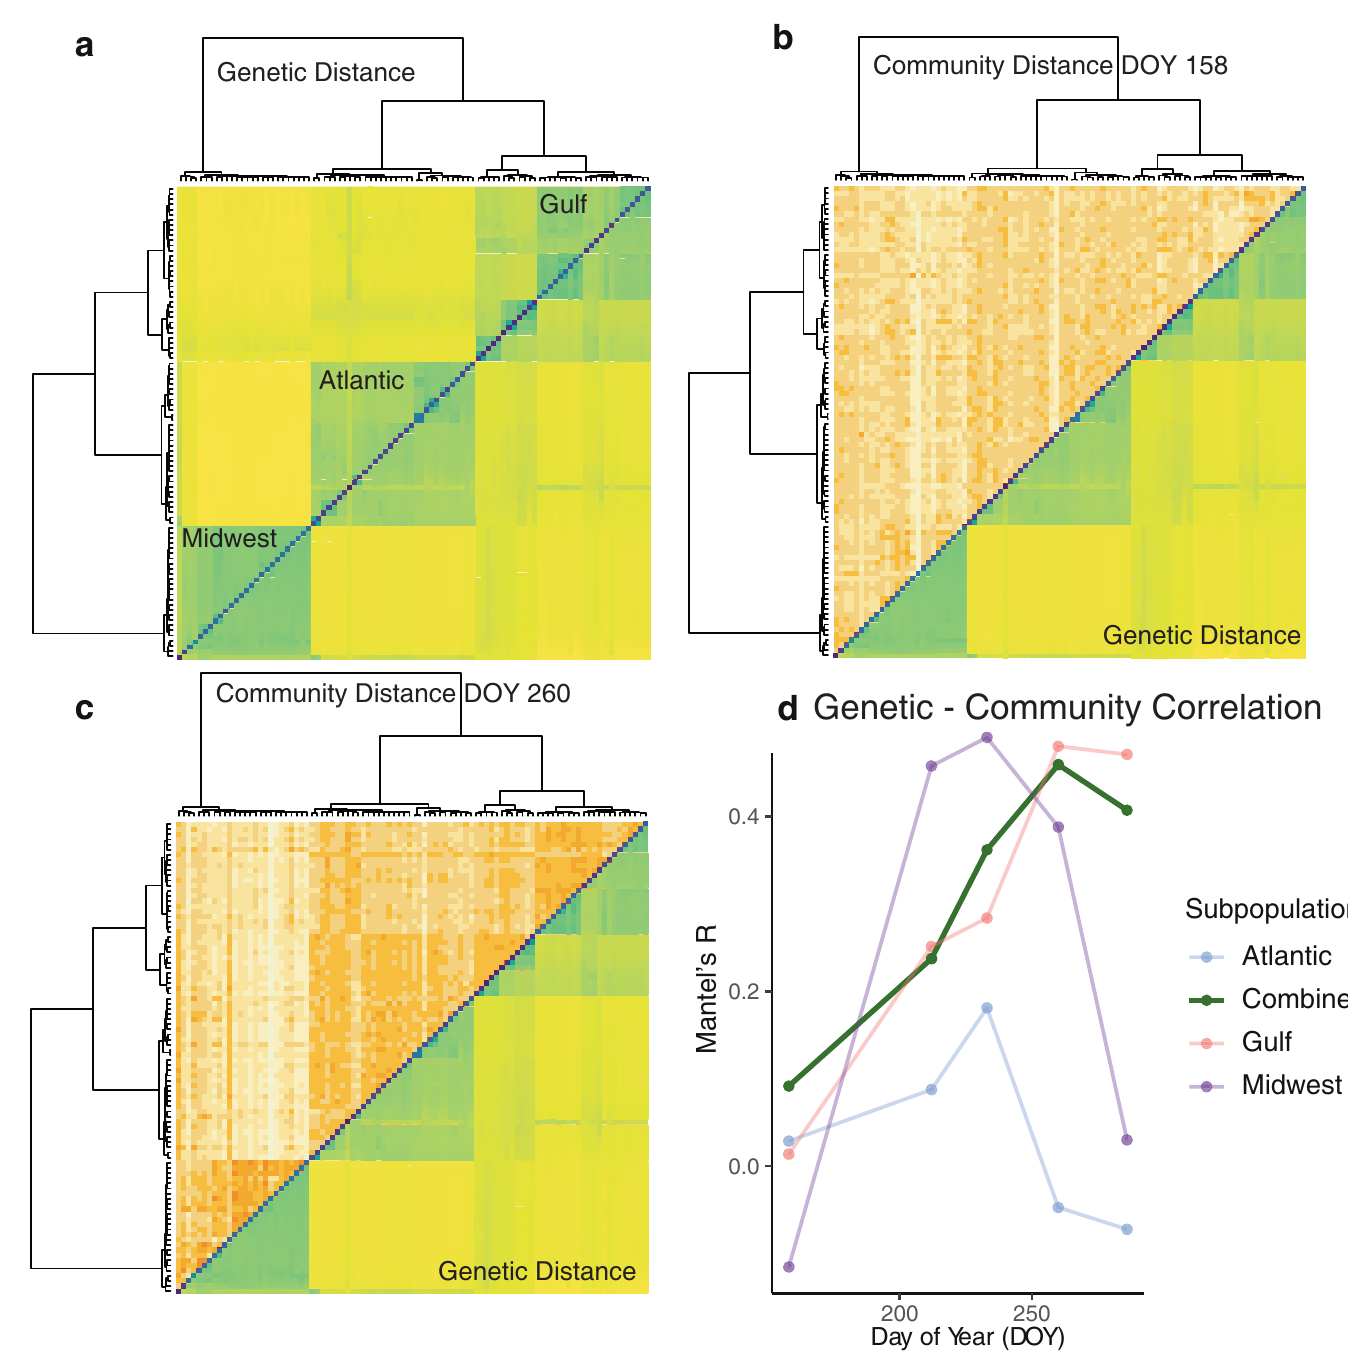
Fig 3. Genetic and fungal community pairwise distance matrices at KBS, Michigan. (A) Pairwise genetic distance ( π ) for all samples. Samples are ordered by hierarchical clustering. (B, C) Pairwise community distance (Bray–Curtis) for all samples, shown in the same order as genetic distances, for 2 sampling times, DOY 158 and DOY 260. Other sampling times shown in Supp. (D) Values of Mantel’s r shown indicate correlation between distance matrices for genetics and fungal communities at each time point, with subsetted subpopulations shown as faint lines. p < 0.01 for all tests in the combined populations. Data underlying this figure can be found in S3 Data. DOY, day of year; KBS, Kellogg Biological